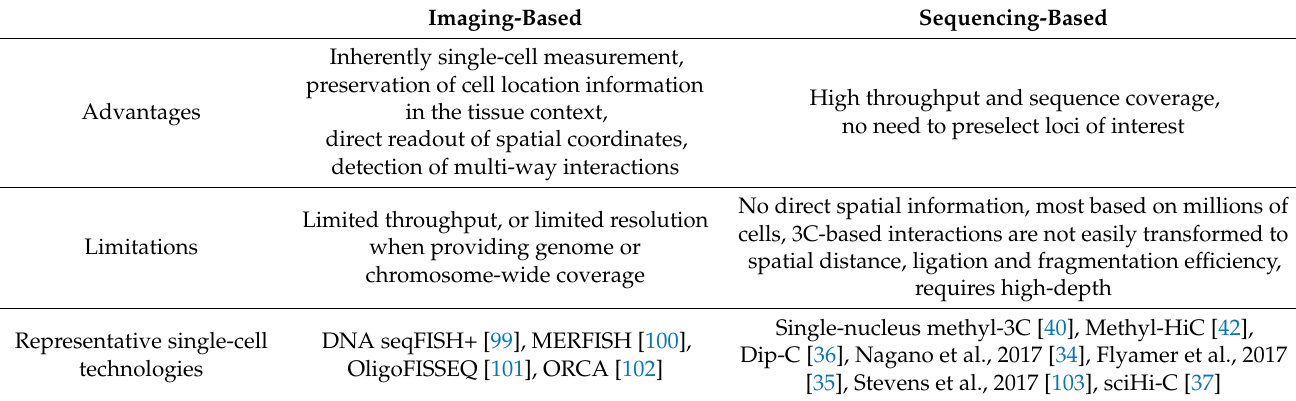
Table 1. Cont. Imaging-Based